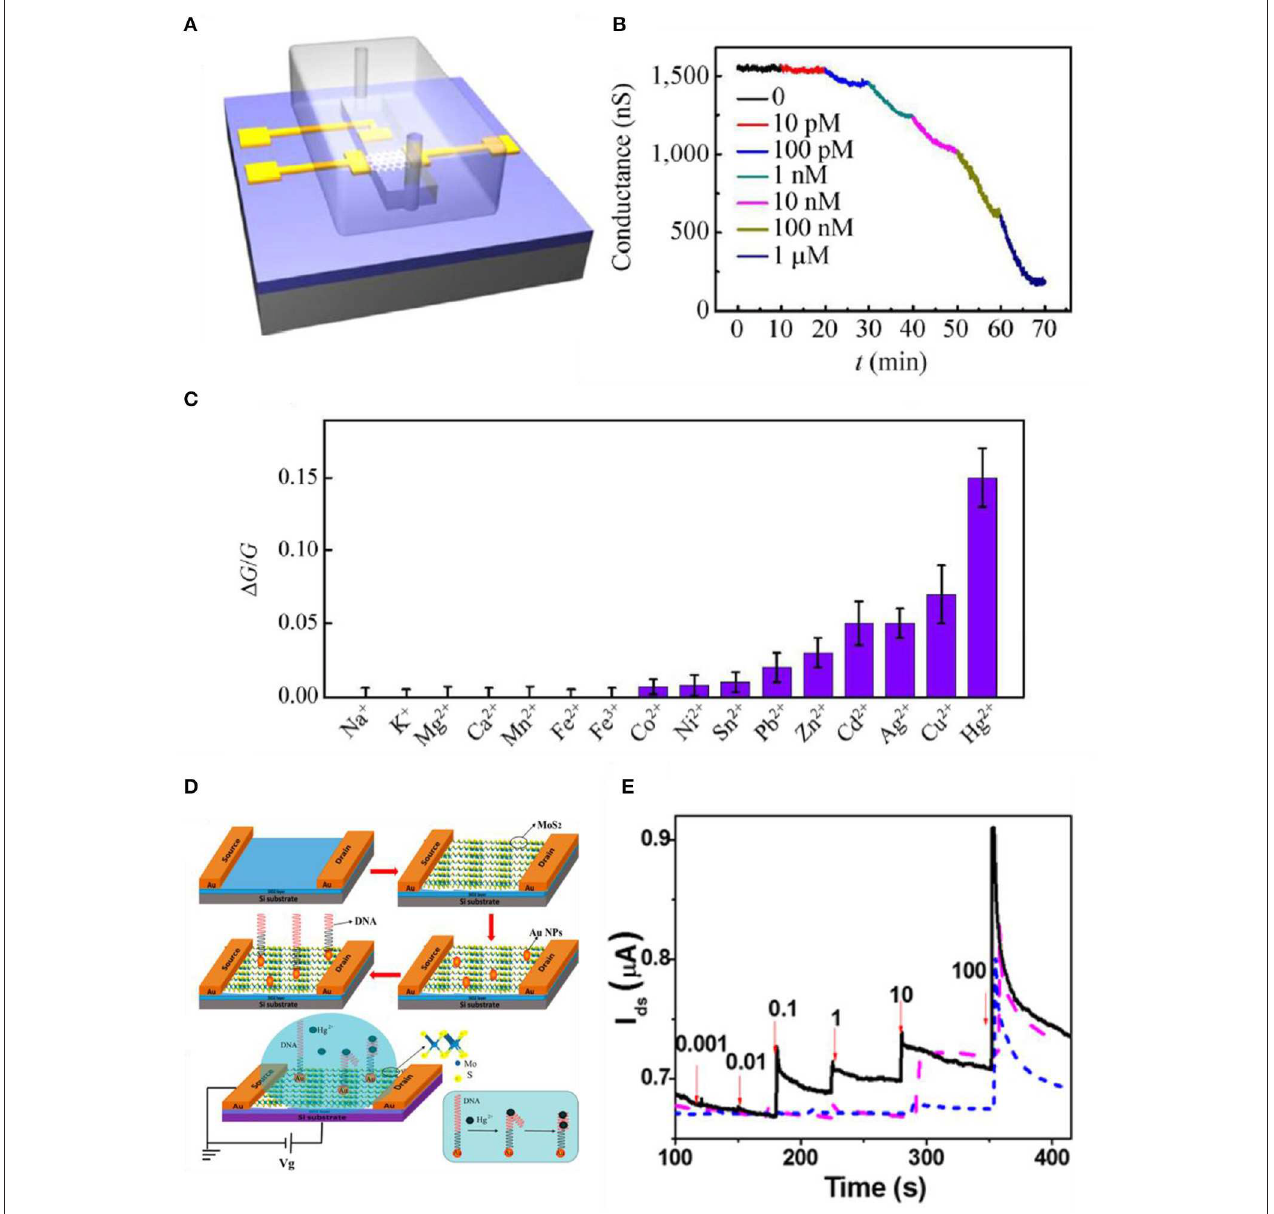
FIGURE 8 | MoS 2 -based FET metal ion sensors. (A) Schematic diagram of microfluidic channel onto MoS 2 device. (B) Sensing curve data using low-concentration Hg 2 + ions. (C) Selectivity to various metal ions having a concentration of 1nM. Figures (A–C) were reproduced from Jiang et al. (2015) with permission from Springer. (D) Illustration of manufacturing process of MoS 2 based FET. MoS2/DNA-Au NPs hybrid structure is shown. (E) Real-time sensing curves of Hg 2 + (nM) in water ( V DS = 0.1V), MoS 2 /DNA-Au NPs (black, solid), MoS 2 -Au NPs (purple, dash), MoS 2 (blue, short dash). Figures (D,E) were reproduced from Zhou et al. (2016) with permission from the American Chemical Society.